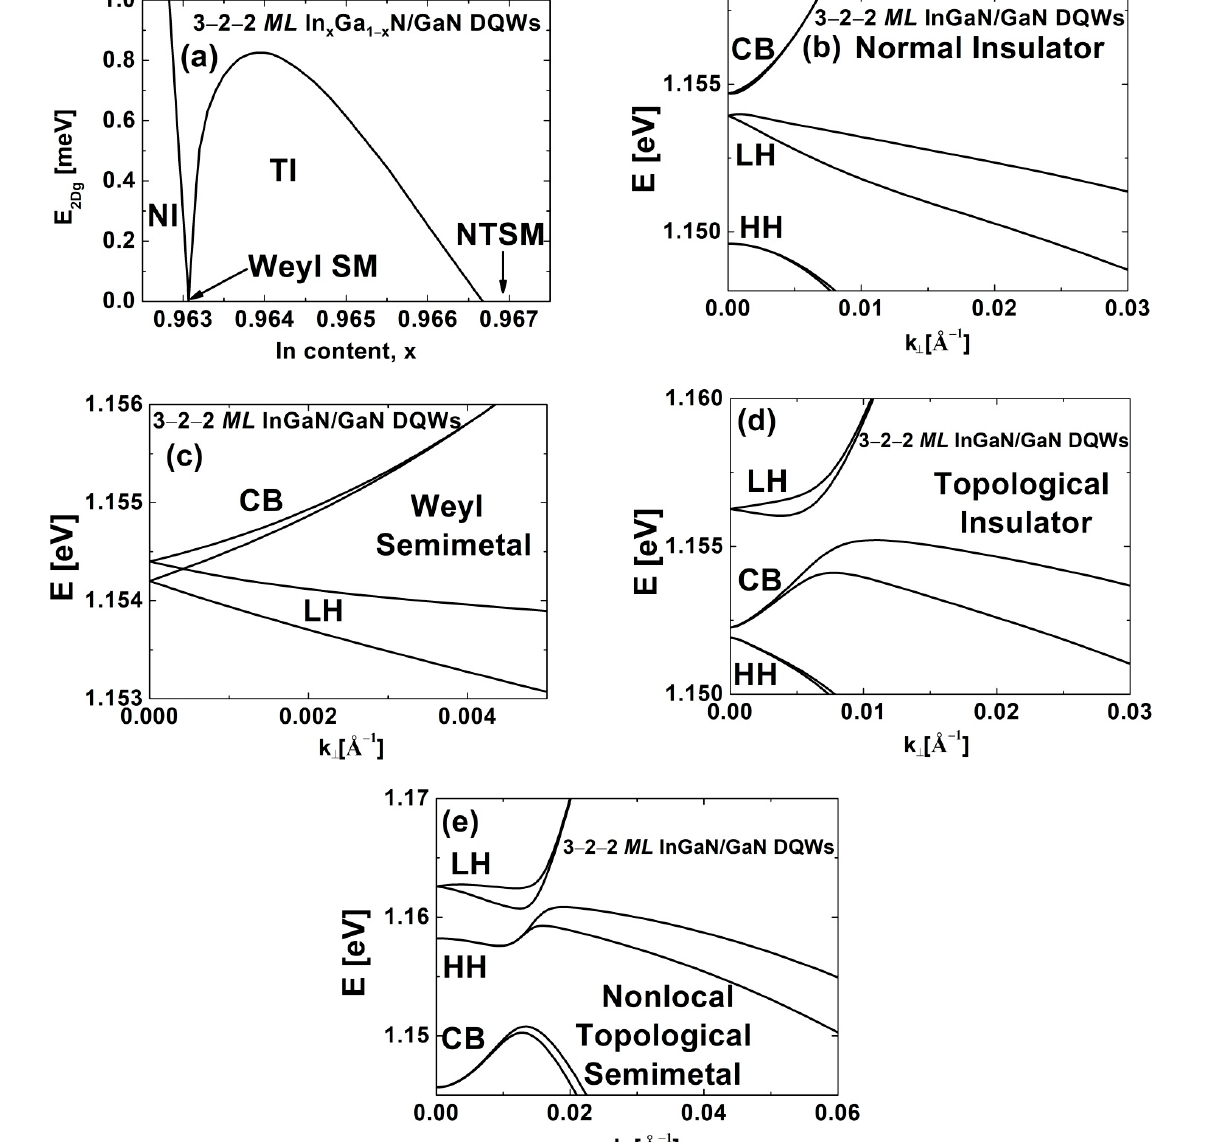
Figure 2. ( a ) The 𝐸 (cid:2870)(cid:3005)(cid:3034) for In x Ga 1 − x N/GaN DQWs with 𝐿 (cid:3044)(cid:3050),(cid:3002) = 3 𝑀𝐿𝑠 , 𝐿 (cid:3044)(cid:3050),(cid:3003) = 2 𝑀𝐿𝑠 , and 𝐿 (cid:3036)(cid:3029)